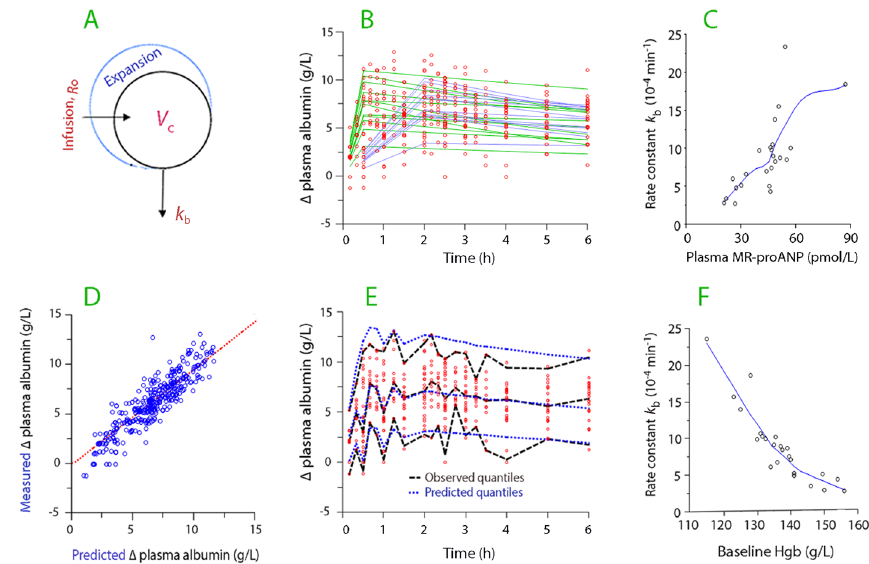
Fig. 4 Albumin kinetics. A Schematic drawing of the volume kinetic model. B Curve-fit in the final model for the dilution-corrected change in plasma albumin concentration versus time. C Increase in the rate constant for capillary leakage of albumin for increasing plasma MR-proANP concentrations. D Predicted versus measured dilution-corrected change in plasma albumin concentration in the final model. E Original data (red points) with the associated 5%, 50%, and 95% quantiles (black lines) and the corresponding quantiles obtained by predictive check based on 1000 simulations using the model parameters in the final model (blue lines). A small difference between observed and predicted quantiles indicates good model performance. F